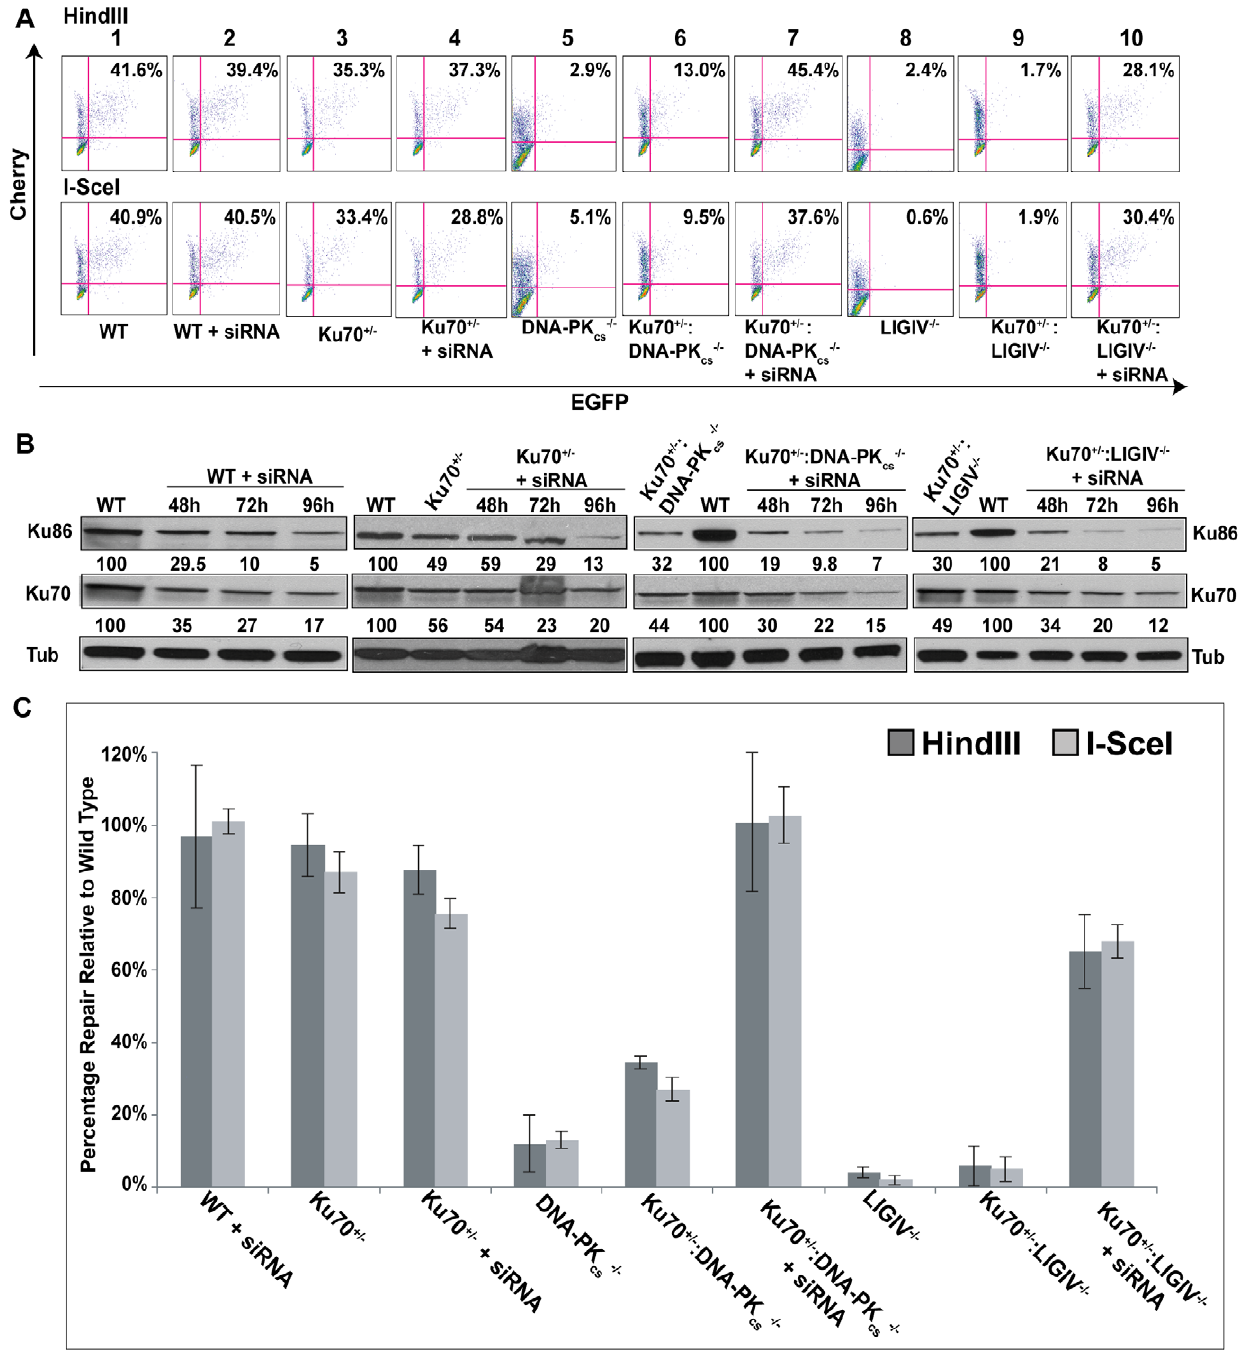
Figure 6. The reduction of Ku results in elevated levels of end joining in C-NHEJ mutant cell lines. (A) FACS profiles using the pEGFP- Pem1-Ad2 reporter substrate are shown for the indicated cell lines. The profiles for the Top and Bottom panels were generated using HindIII - and I- SceI -linearized plasmids, respectively. The percent of the substrate that was repaired is shown in the right-hand corner of each profile. (B) Western blot analyses demonstrate a reduction in Ku protein levels. Western blots for extracts derived from the indicated cell lines are shown using antibodies against either Ku86, Ku70 or (as a loading control) tubulin (Tub). Each of the blots was quantitated using a phosphoimager and the level of a particular Ku subunit relative to the amount expressed in the parental cell line is indicated below each blot. (C) Four independent experiments comparable to those depicted in (A) were performed and the average percent repair is shown with the standard deviation. reverted the repair events to a C-NHEJ spectrum. Again, the degree of complementation was directly related to the degree of complementing tantly, the re-introduction of a wild-type DNA-PK cs or XLF cDNA, into their respective null cell line, partially and completely, respectively, protein expression achieved in these cell lines (data not shown).